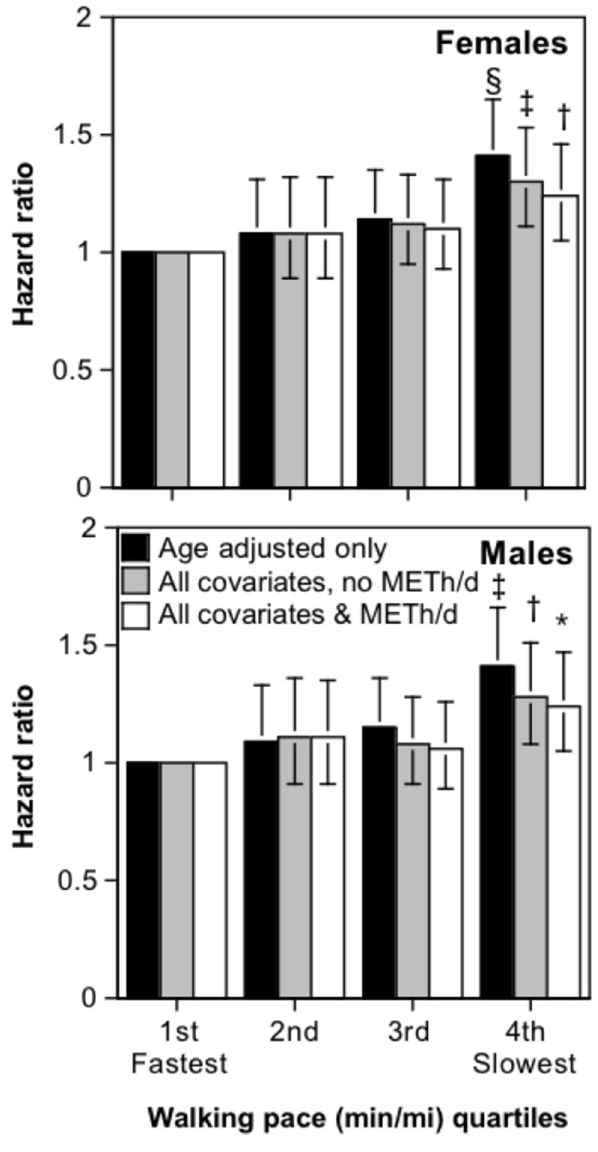
Figure 1. Hazard ratio for all cause mortality by quartiles of walking pace (min/mi, highest quartiles slowest pace) adjusted for age (age and age 2 ). Standard covariates include education, smoking status, daily intakes of alcohol, meat and fruit, aspirin use, and prior heart attack. Additional adjustment for walking energy expenditure where indicated.